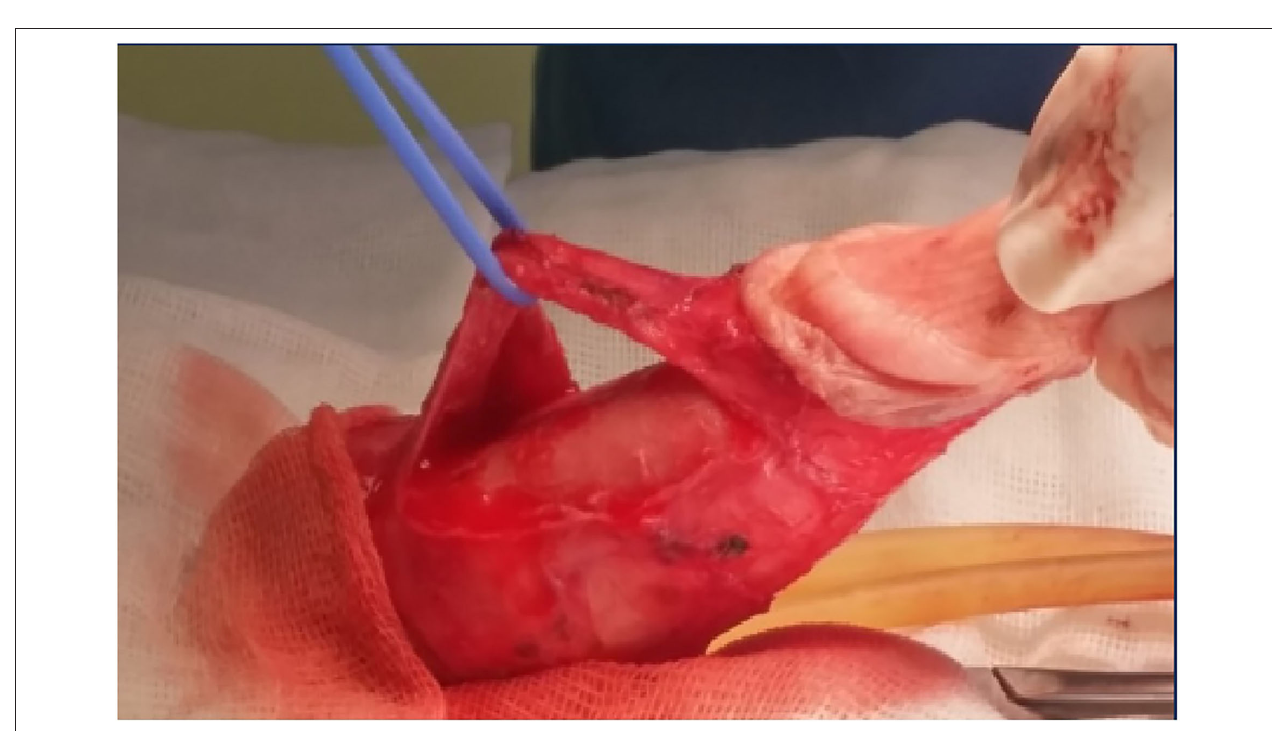
FIGURE 2 | Isolation of neurovascular bundle.